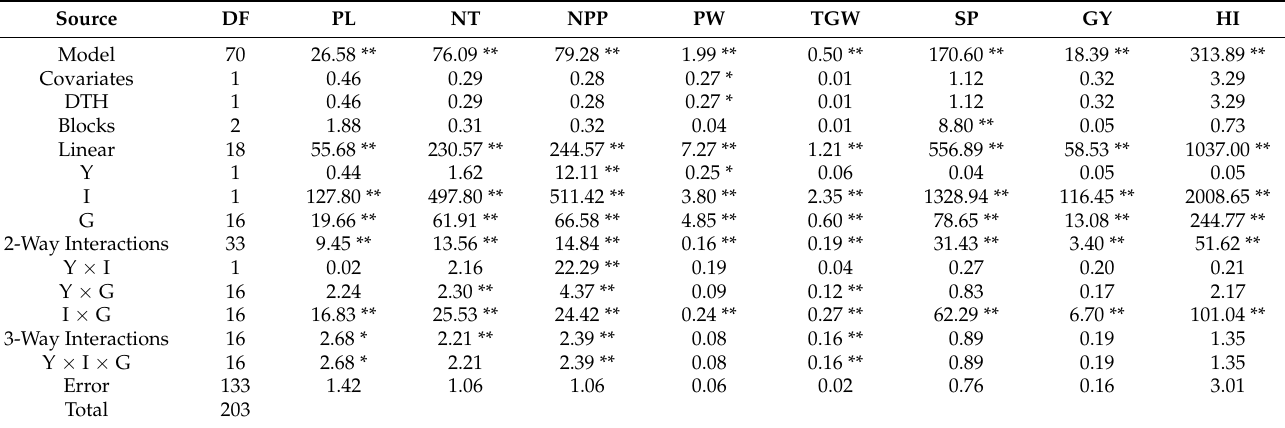
Table 6. Analysis of covariance for agronomical